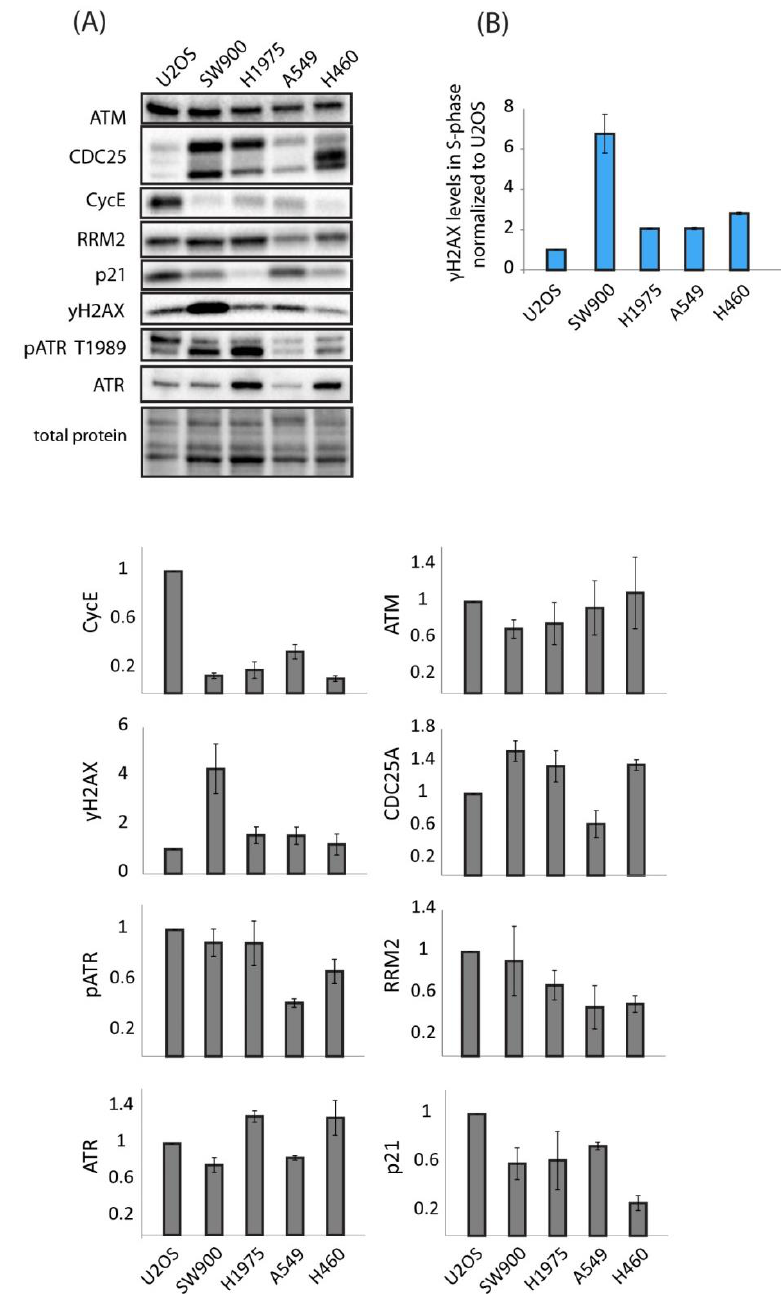
Figure 7. Expression levels of proposed biomarkers of WEE1 and ATR inhibitor sensitivity in lung cancer and U2OS cell lines. ( A ) Immunoblot of lysates from exponentially growing cells. Bar charts (grey) show quantifications of protein levels relative to total protein and normalized to the levels in U2OS. Error bars: SEM (n ≥ 3). ( B ) Flow cytometry analysis of γH2AX levels in S-phase of exponentially growing cells normalized to U2OS. Error bars: SEM (n = 2).